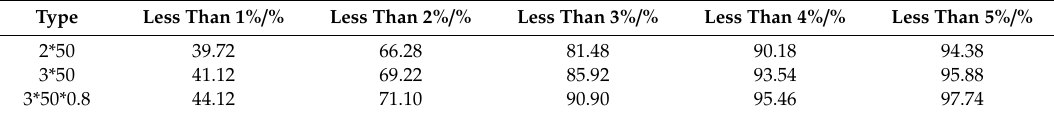
Table 12. Comparison of error distributions.